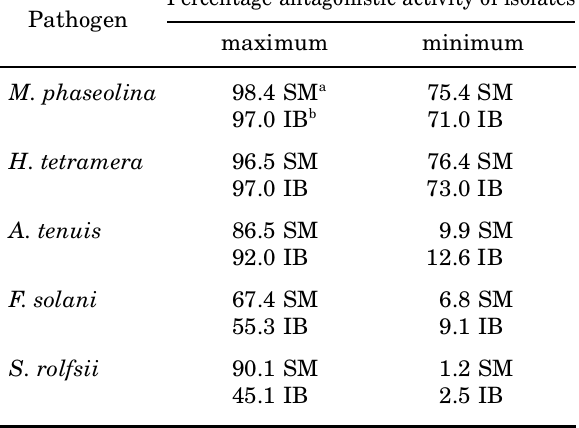
Differences between means followed by the same letter are not significant. Table 3. Maximum and minimum percentage of reduc- tion of fungal growth caused by bacterial isolates from phylloplane of eggplant (SM) and sweet potato (IB) plants in relation to control